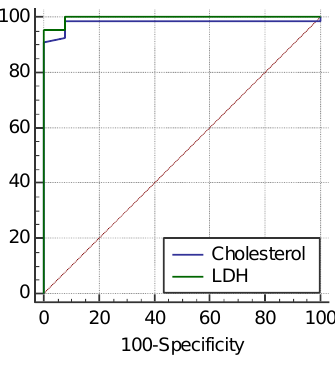
Figure 1. ROC Curve analysis in exudative